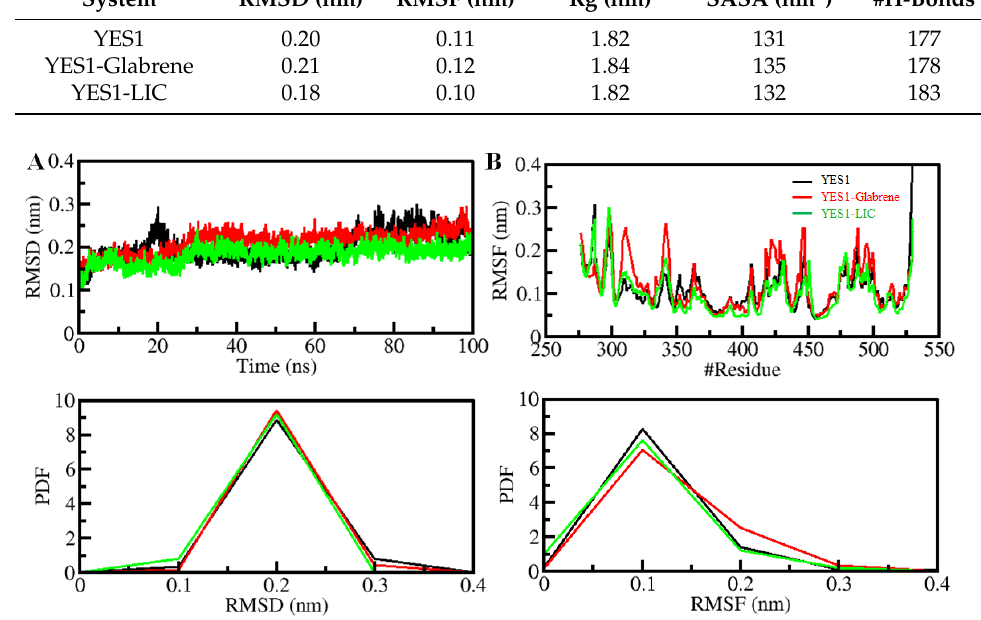
Figure 3. Structural dynamics of YES1 upon Glabrene and LIC binding. ( A ) RMSD plot of YES1 in complexed with Glabrene and LIC. ( B ) RMSF plot of YES1 and its complex with Glabrene and LIC. Lower panels show the probability distribution function of values as PDF. # represents number. Table 5. The average values of different MD parameters calculated after 100 ns simulations.